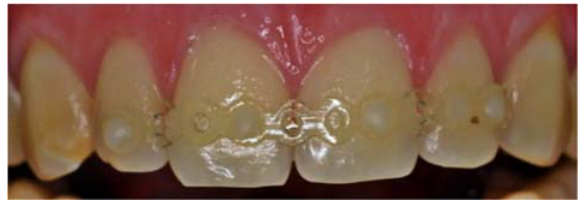
Figure 3. The power chain—composite splint.